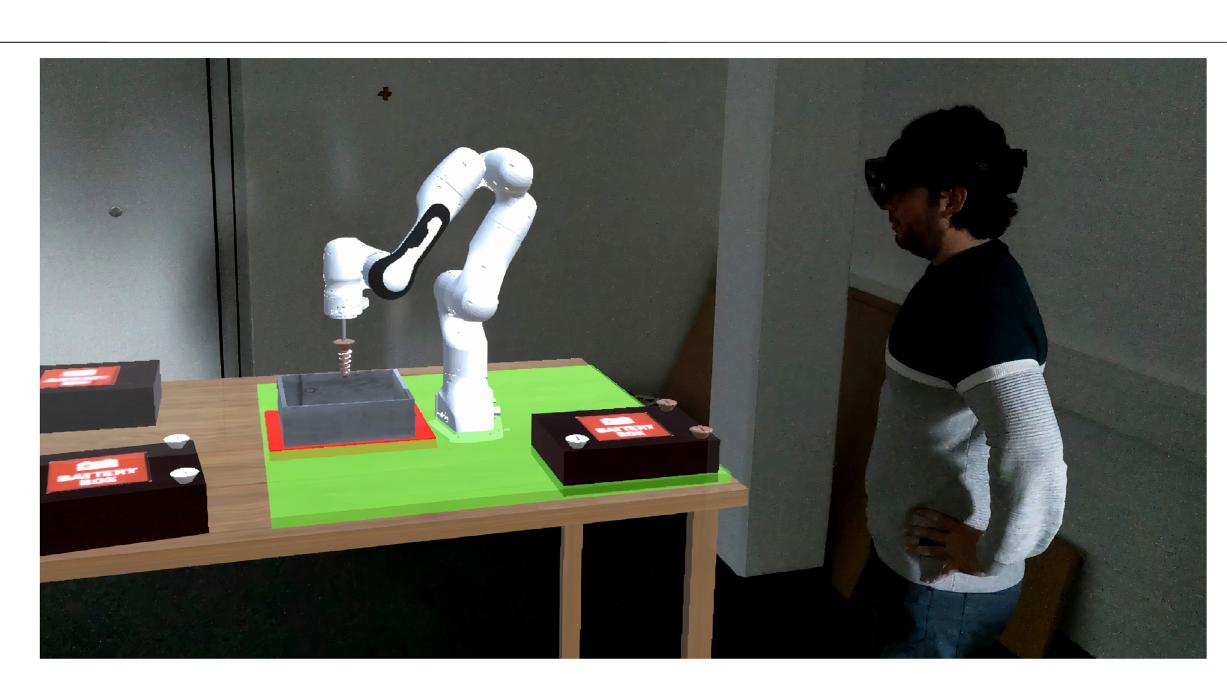
Frontiers in Arti fi cial Intelligence |